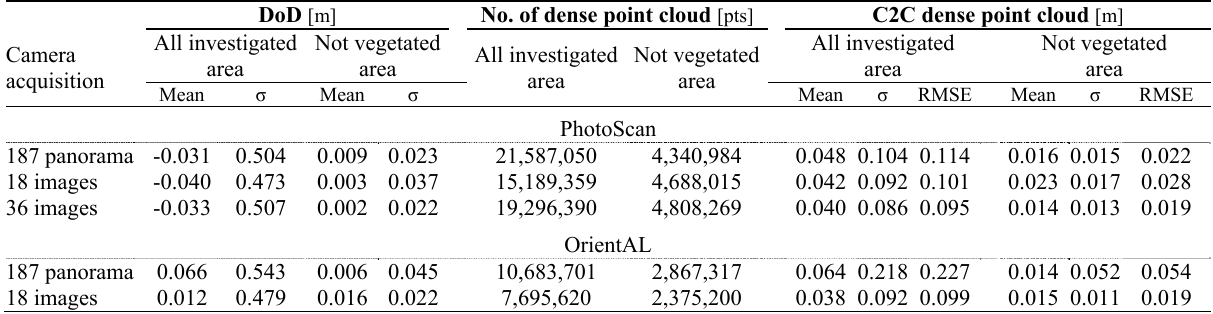
Table 2. Accuracy assessment based on the elevation difference (DoD) and the absolute distance (C2C) between the photogrammetric data and the TLS reference data for each camera acquisition dataset processed by PS and OA. The TLS acquisition provided 21,292,050 and 6,235,258 points for the entire investigated area and for the area not covered by vegetation,